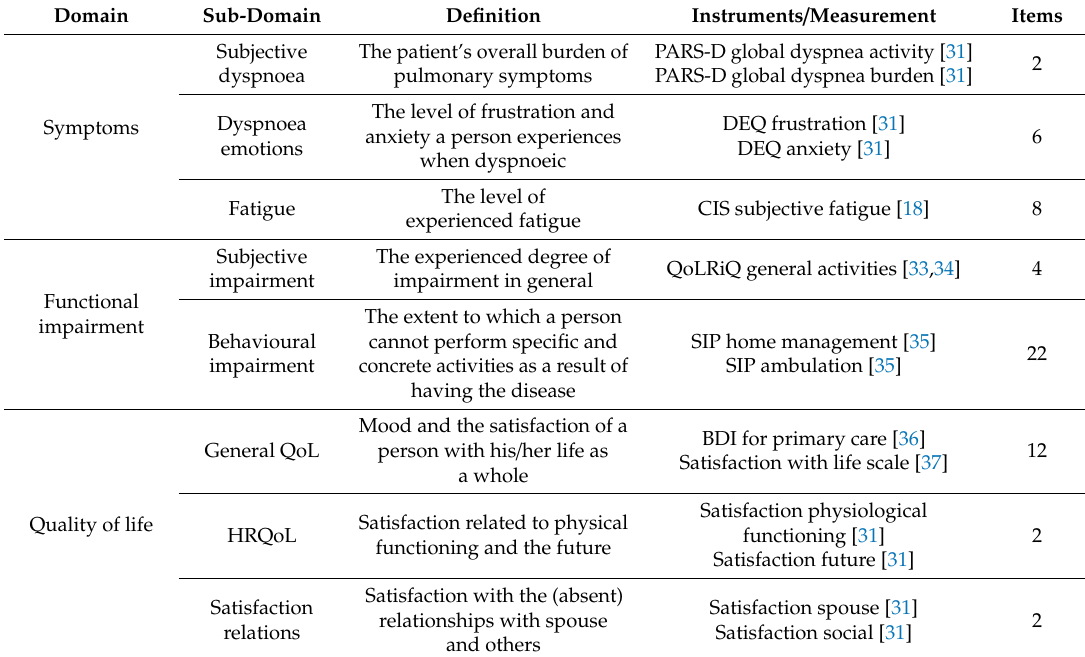
Definitions and instruments of the sub-domains of the Nijmegen clinical screening instrument